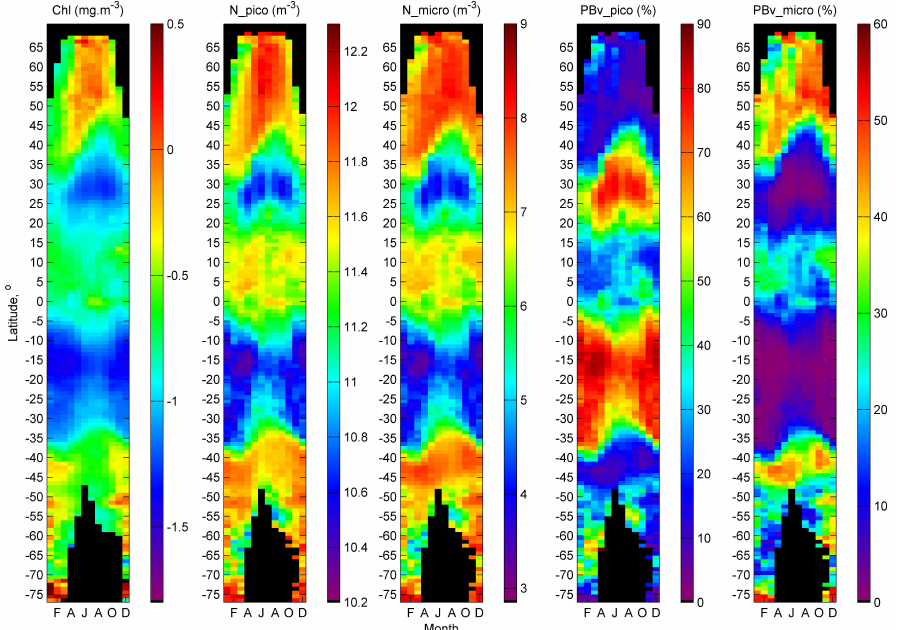
Fig. 9. Meridional-time transects along 30 ◦ W of SeaWiFS OC4v4 Chl (leftmost panel, color scale in log10 space) and several relevant SeaWiFS PSD algorithm products (from left to right, particle number concentration in the picoplankton (0.5 to 2µm in diameter) and microplankton (20–50µm) size ranges, and percent particle volume due to picoplankton and microplankton. The resolution is 1 degree by 1 month; values for each month were obtained by taking the spatial mean of a 4 × 4 pixel box from the monthly decadal average images. Color scales are in log10 space for the first three panels and linear for the last two.